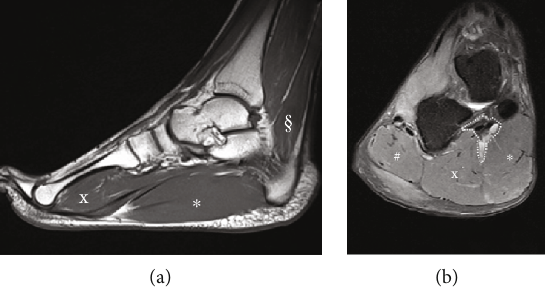
Figure 3: Sagittal (a) and coronal (b) MRI scans show hypertrophy of abductor hallucis ( ∗ ), fl exor digitorum brevis (x), abductor digiti minimi (#), and accessorius soleus muscle